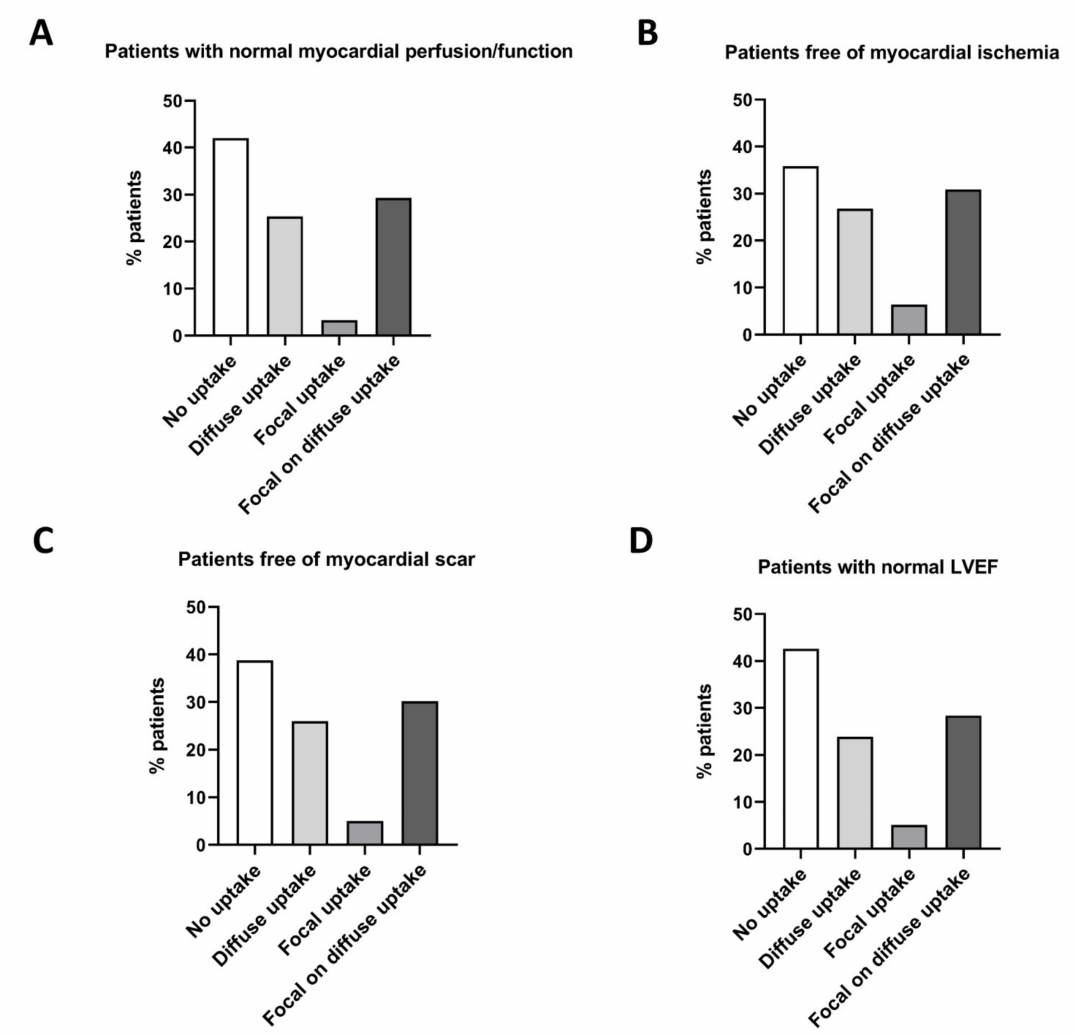
Figure 3. Left ventricular 18 F-FDG-PET / CT uptake pattern in patients with normal myocardial perfusion imaging (MPI) findings. ( A ) Patients with normal myocardial perfusion / function. ( B ) Patients free of myocardial ischemia. ( C ) Patients free of myocardial scar. ( D ) Patients with a normal left ventricular ejection fraction